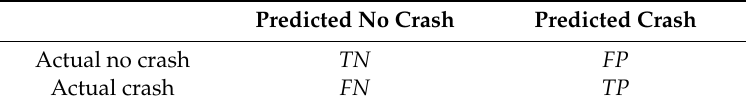
Table 3. Confusion matrix for two-class